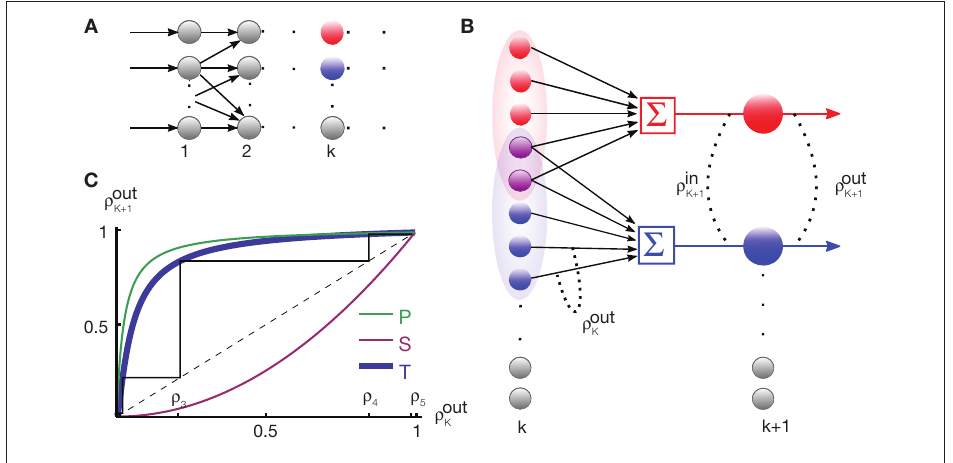
correlation from layer-to-layer. (C) Iteration of the dynamical model described in the text. The green line represents the pooling map P , the pink line is the decorrelating transfer map, S (here chosen to be S( r ) = r 2 ). The solid blue line represents their composition, T = S ± P , which maps output correlations from layer k to output correlations from layer k + 1. The solid black line shows the trajectory in = , n obtained by iterating the map with r = 600, e 1 0 n = 400, p = i